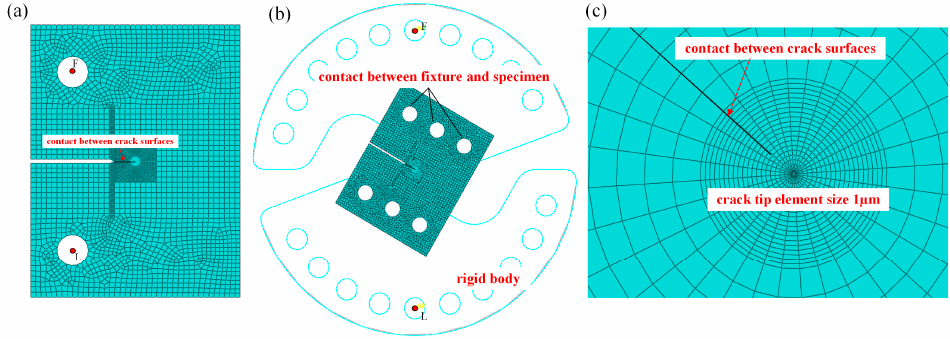
Figure 2. Finite element model: ( a ) mode I crack, ( b ) I-II mixed mode crack, ( c ) mesh detail.